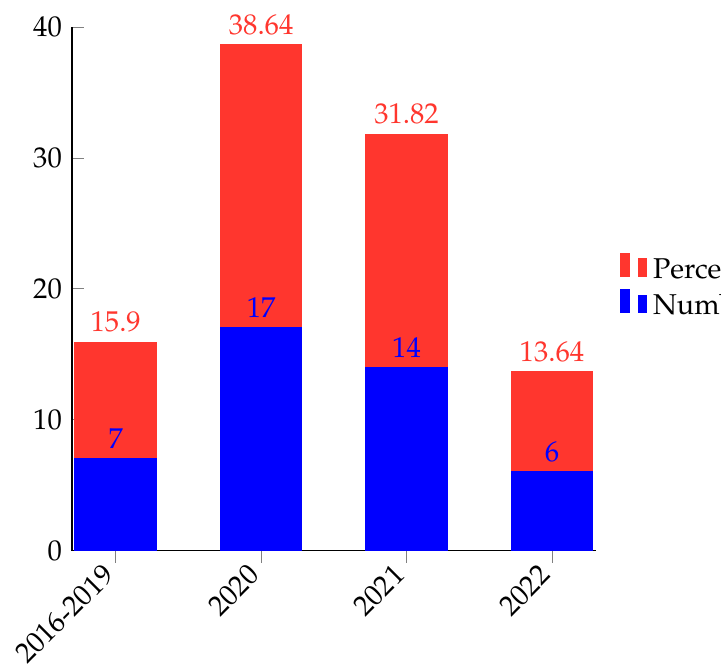
Figure 7. Yearly distribution of reviewed research papers